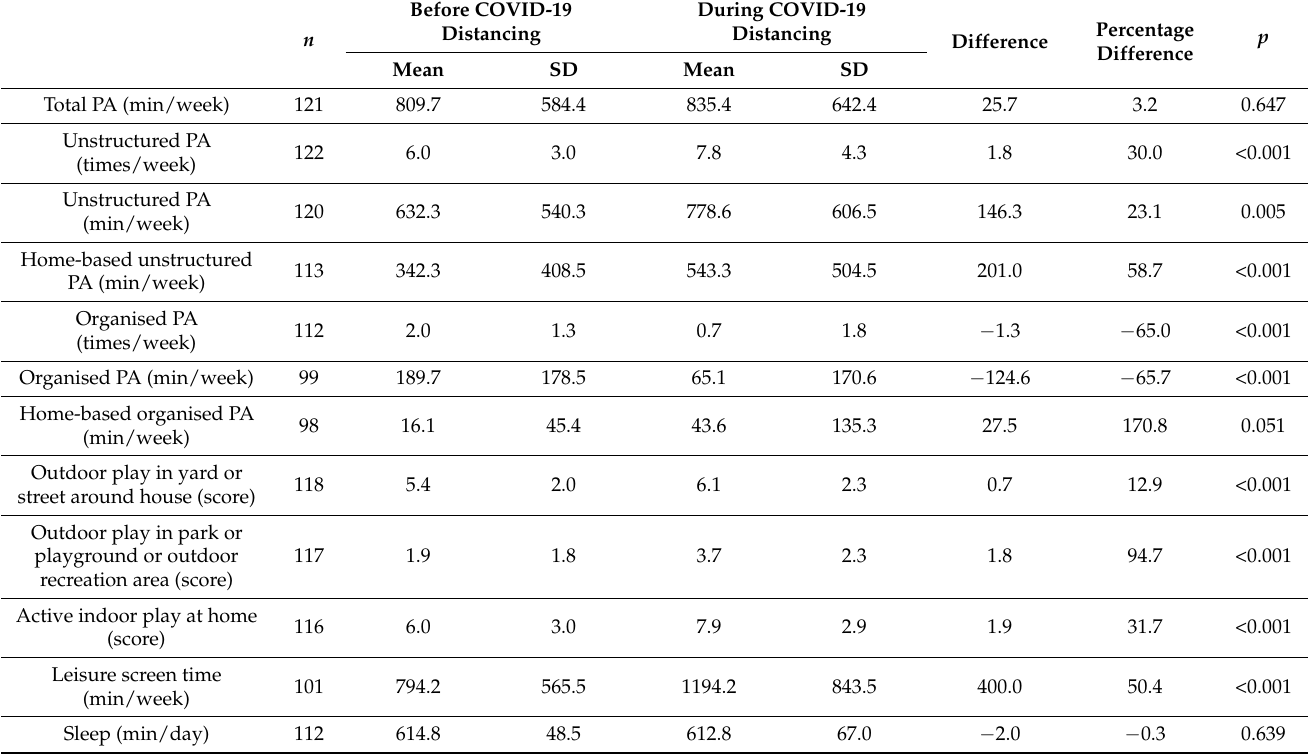
Table 2. Change in movement behaviours from before to during COVID-19